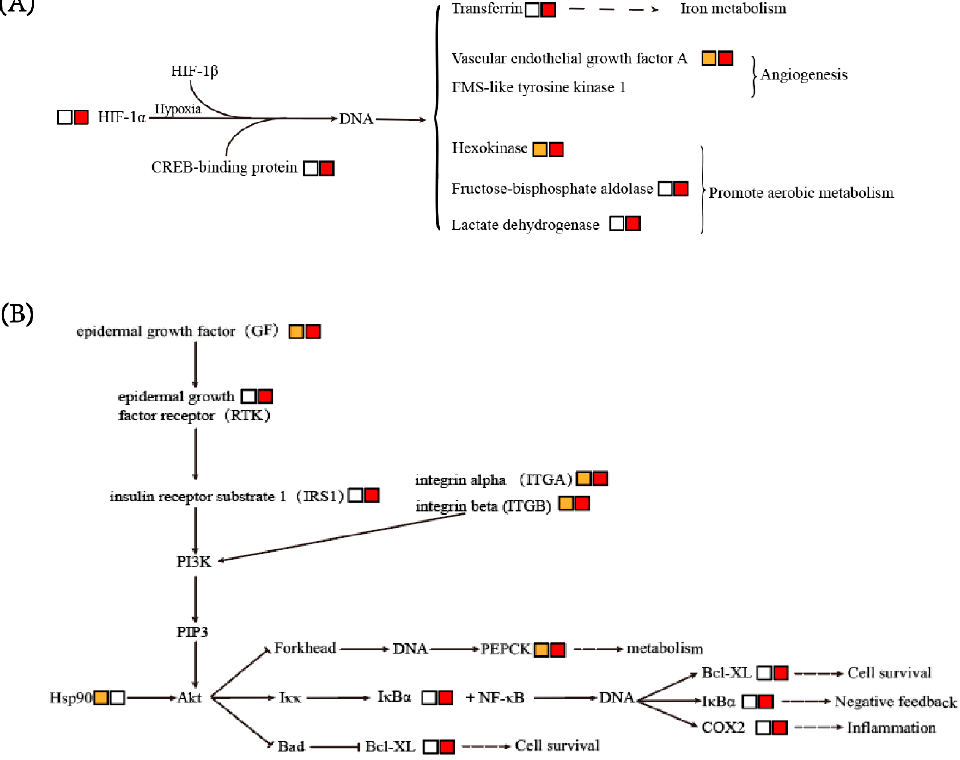
Figure 5. Expression trends of DEGs involved in PI3K-Akt ( A ) and NF- κ B ( B ) signaling pathways. The box showed upregulated DEGs from the 6 hpi vs. 0 hpi comparison (orange), the upregulated DEGs from the 12 hpi vs. 0 hpi comparison (red) and the downregulated DEGs from the 6 hpi or 12 hpi vs. 0 hpi comparisons (black).